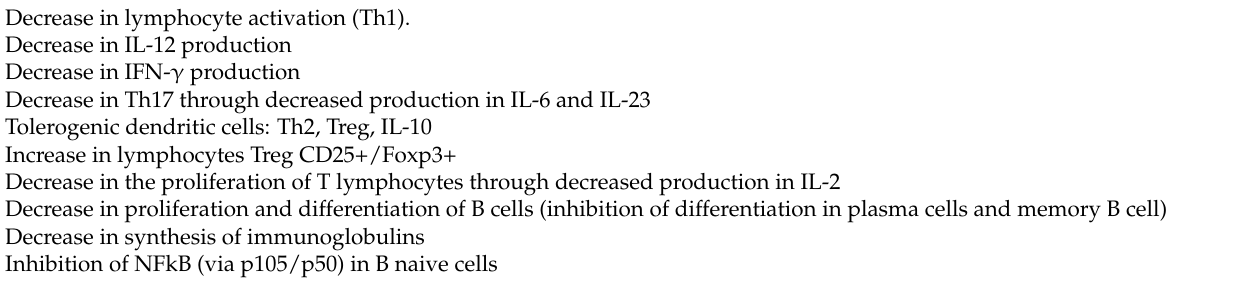
Table 2. Effects of vitamin D in the immune